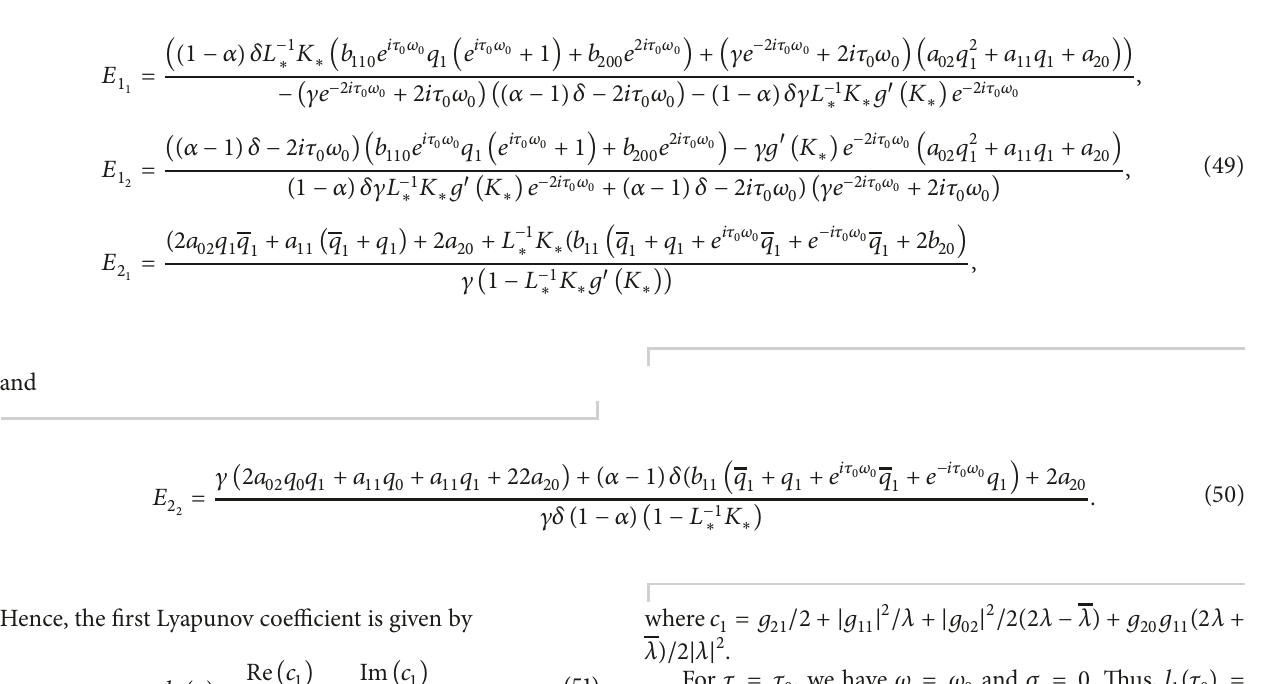
Figure 1: For 𝛼 = 0.5 , an unstable periodicsolution bifurcatesfrom the positive equilibrium: (aand b)for 1.5718 < 𝜏 0 , existenceof bifurcating periodic solution and (c and d), for 1.572 > 𝜏 0 , absence of bifurcating periodic solution (see Theorem